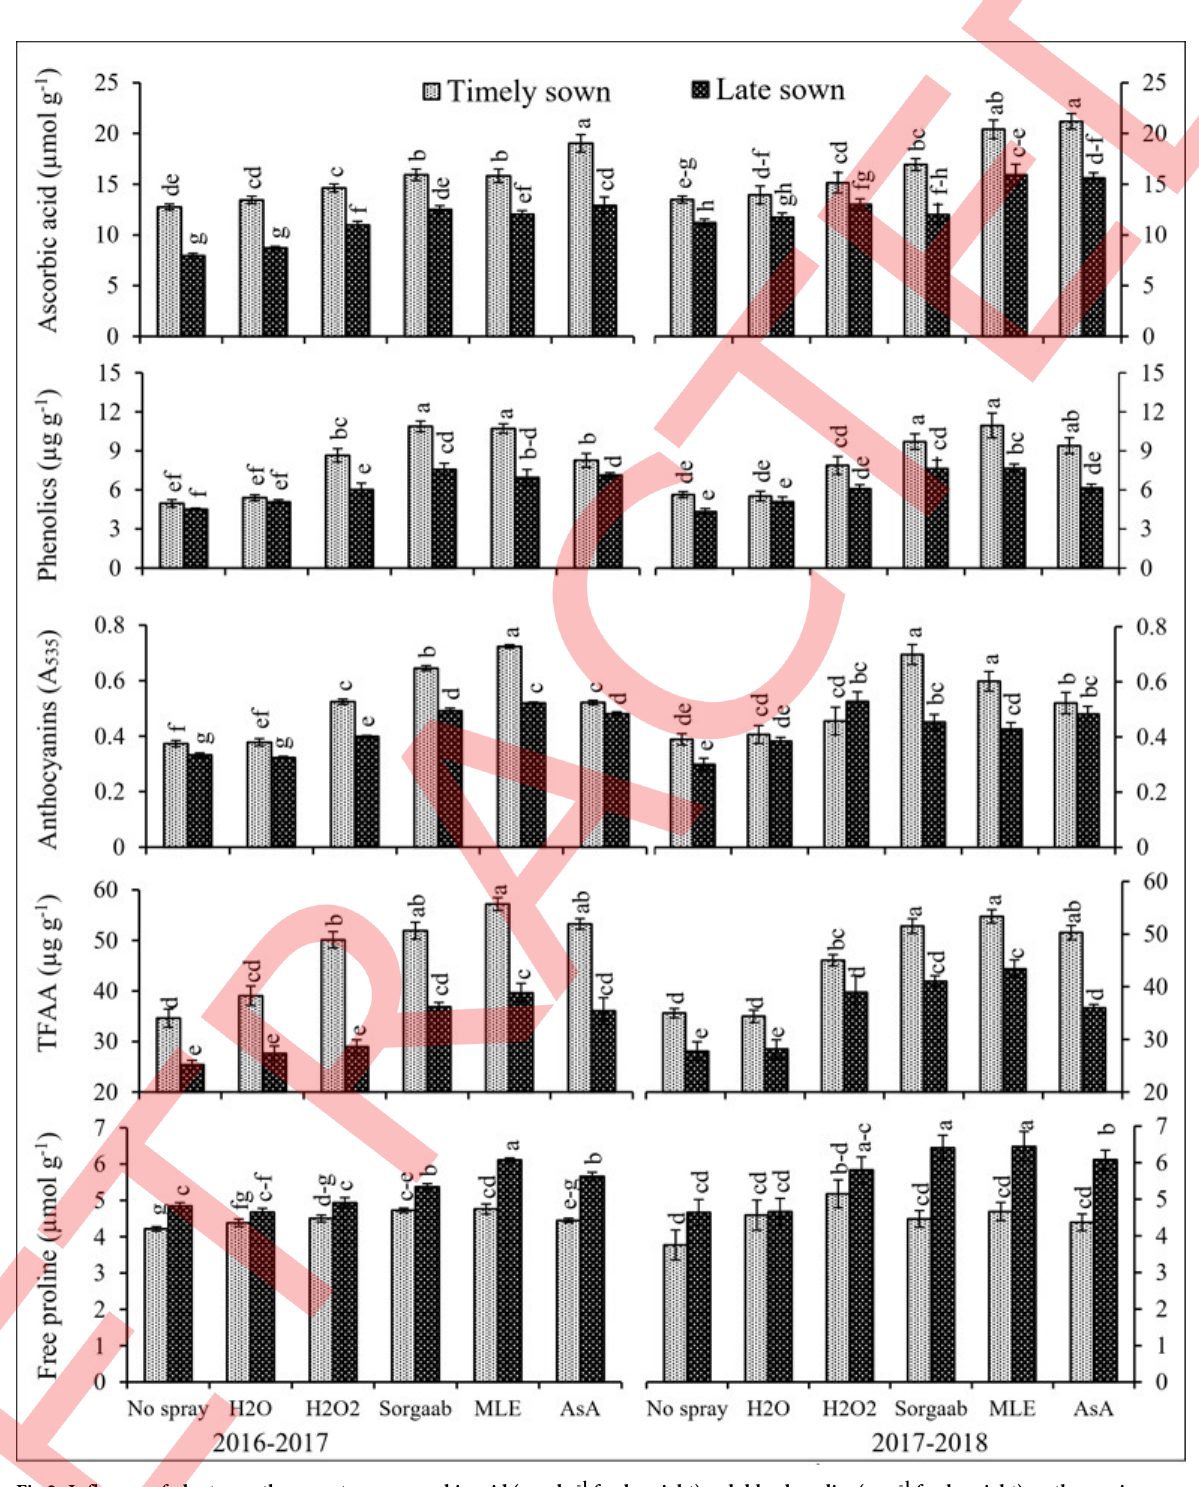
Fig 2. Influence of plant growth promoters on ascorbic acid ( μ mol g -1 fresh weight), soluble phenolics ( μ g g -1 fresh weight), anthocyanins (A 835 ), total free amino acids (TFAA; μ g g -1 fresh weight) and free proline ( μ mol g -1 fresh weight) in seeds of quinoa cultivated under timely and late sown conditions during growing seasons of 2016–2017 and 2017–2018.